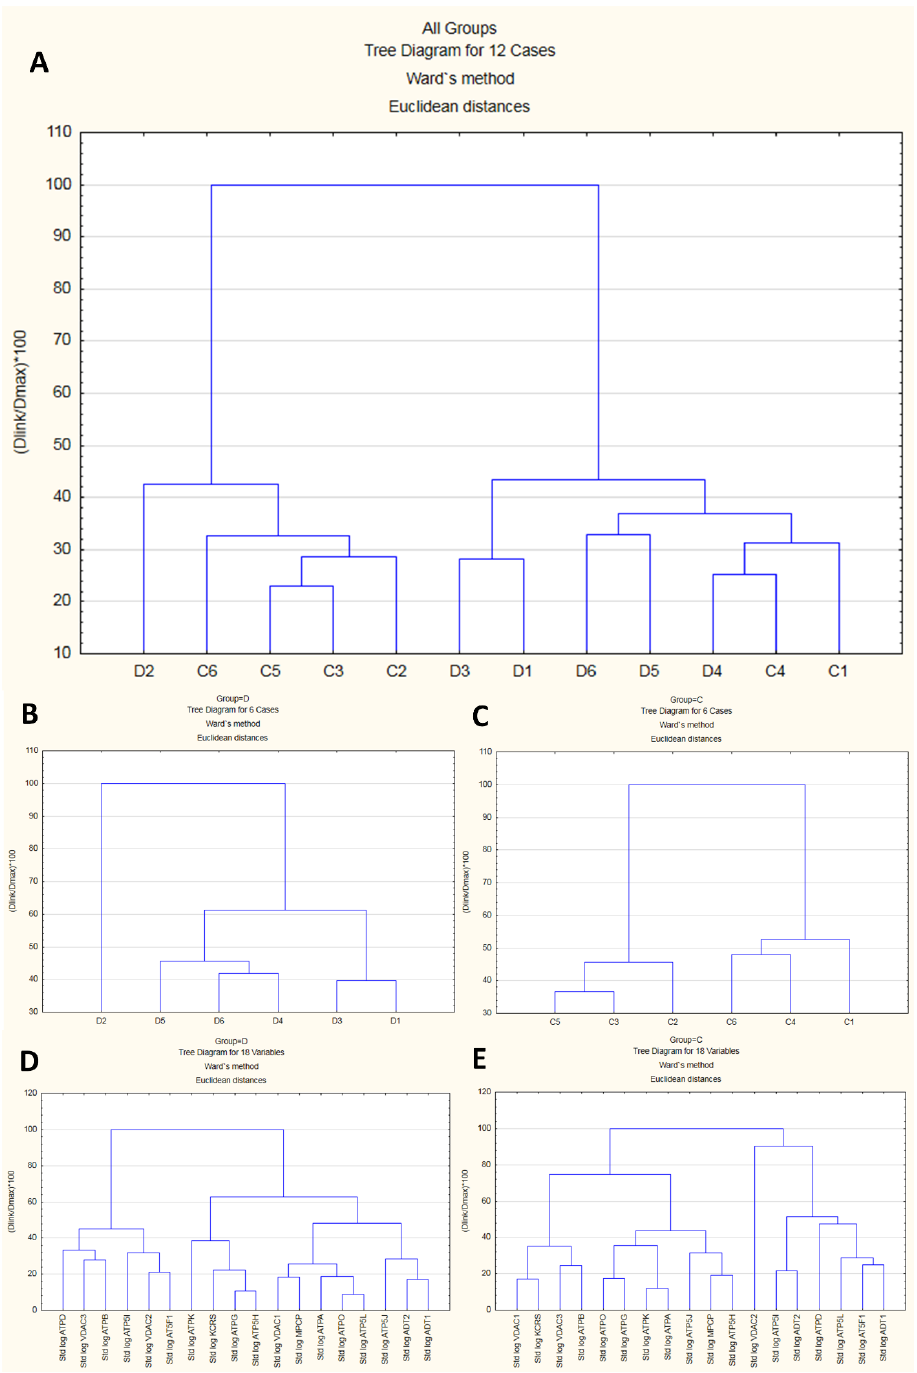
Figure 5. Results of cluster analysis. The upper dendrogram ( A ) shows how sample units (“cases”) plotted on the x -axis are combined into “natural” clusters, the height of each branching point corresponding to the normalized distance at which two clusters are joined. The middle left and middle right dendrograms, ( B ) and ( C ), depict the situation in subgroups ( D ) and ( C ), respectively. Similar cases were more strongly associated, i.e., showed smaller distances than dissimilar cases. The lower left and lower right dendrograms, ( D ) and ( E ), depict relationships among 18 mPTP proteins under the D and C conditions,